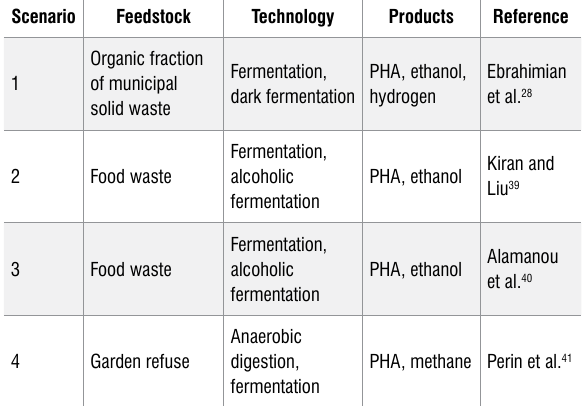
Proposed biorefinery scenarios for the primary production of